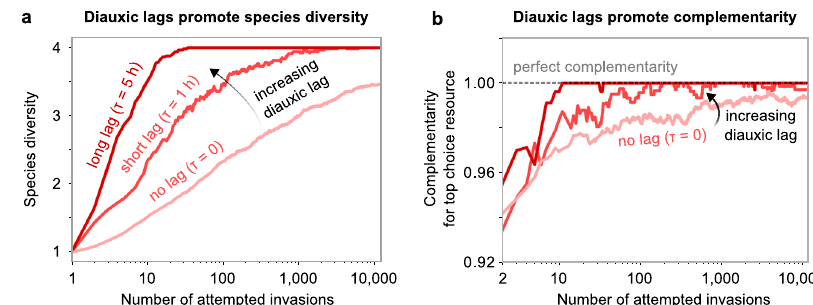
Fig. 5 Diauxic lags further strengthen complementarity for top choice resources. a Species diversity of communities during community assembly, averaged over 100 independent community assembly simulations of our model. The plot shows three cases: with no diauxic lags τ = 0 (pink), with a short lag τ = 1 h for all species (light red), and with a long lag τ = 5 h for all species (dark red) between all resources ( “ Methods ” ). b Complementarity for the top choice resource during community assembly, averaged over the same simulations in ( a ). The horizontal dashed line highlights perfect complementarity, i.e.,